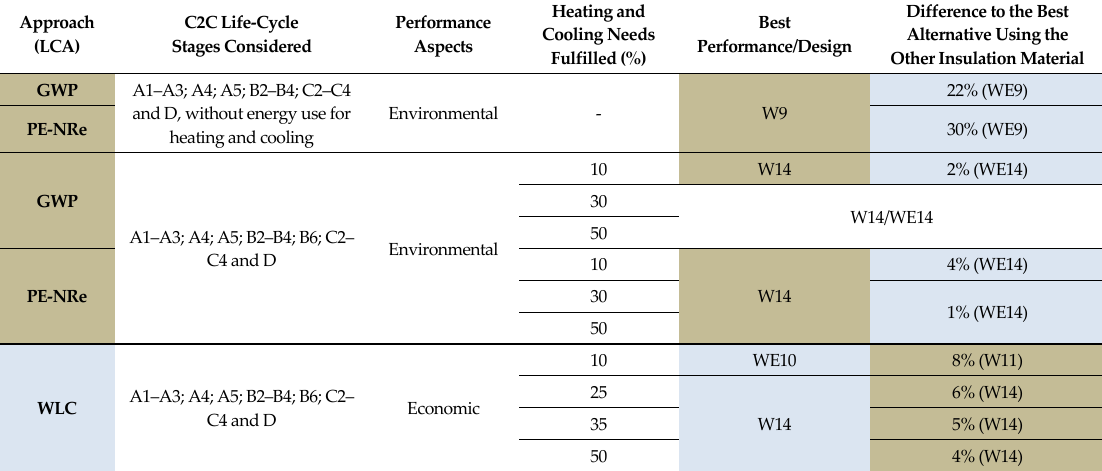
Table 7. Cavity wall solution with the best performance, without considering the reference wall (the colour of each row depends on the best performing solution for each indicator: Brown for ICB and blue for EPS).